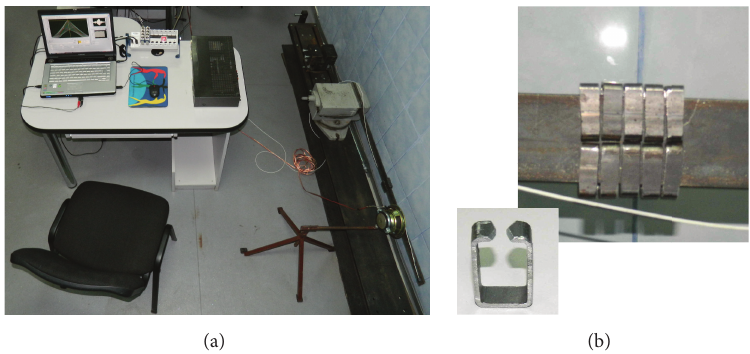
0.00.51.01.52.02.53.03.54.0